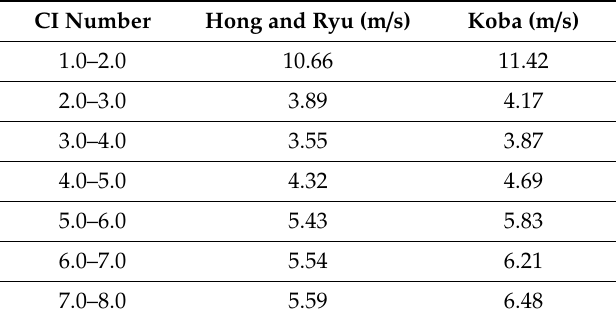
Figure 9. ( a ) MWS (best track) vs. MWS (Hong and Ryu scale) and ( b ) MWS (best track) vs. MWS (Koba scale) for an independent sample of northwestern Pacific TCs in 2013 – 2014. Table 5. RMSEs values for each CI number according to the Hong and Ryu and Koba scales using the ADT TC intensity data (2013 – 2014).